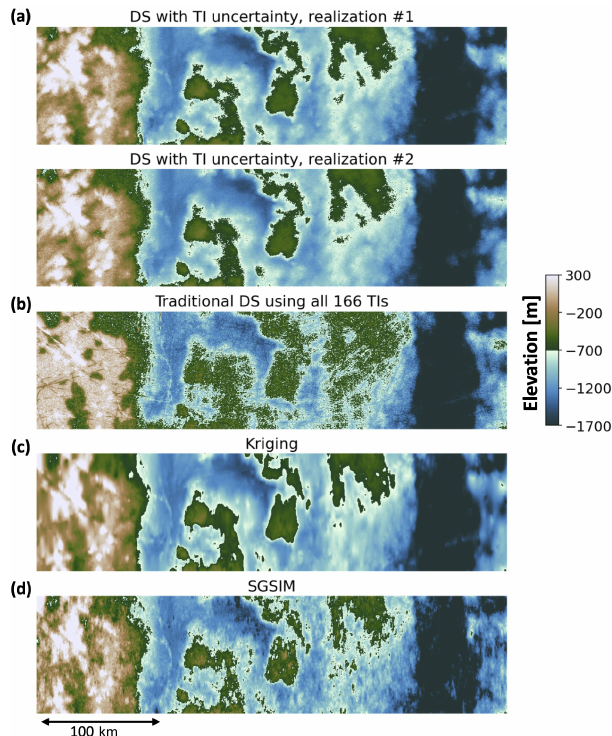
Figure 12. (a) Two topographical model realizations from using our proposed DS with uncertain TI sampling to fill the radar line gaps. The model realization number corresponds to the TI realiza- tion number in Fig. 11. (b) Line gap filling by traditional DS using all the 166 TIs (without TI sampling). Panels (c) and (d) show line gap filling using kriging and SGSIM.